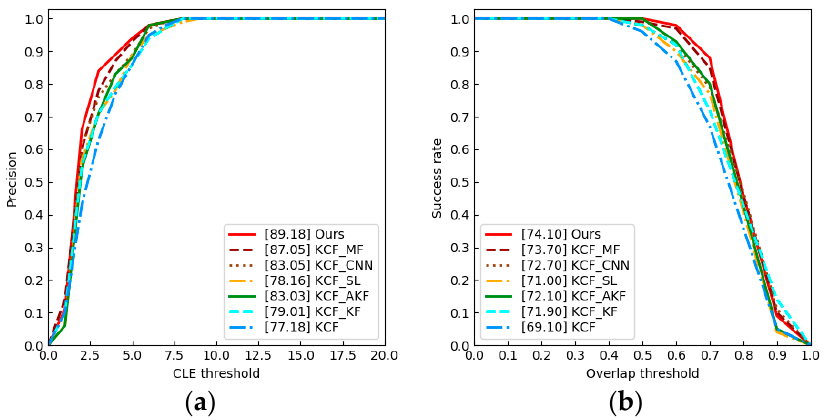
Figure 7. Ablation study on all the unoccluded video sequences. The legend in the precision and success plot are the precision and AUC value score per object tracker, respectively. ( a ) Precision plots; ( b ) Success plots. Table 2. The experimental ablation results of all un-occluded video sequences (in bold the optimal results per tracker).